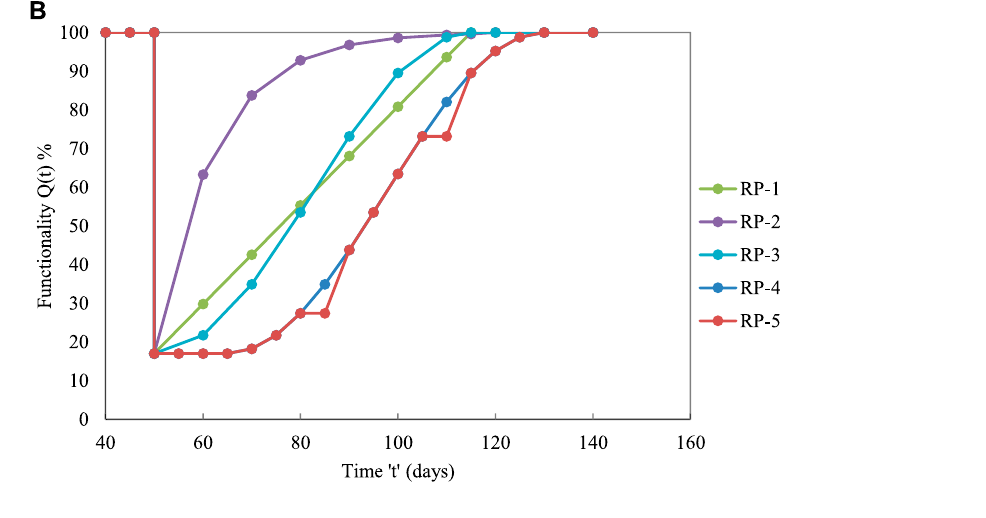
Frontiers in Built